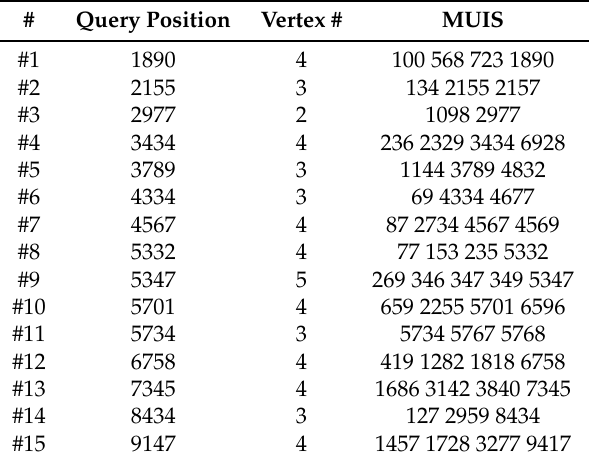
Table 2. Experimental results on the